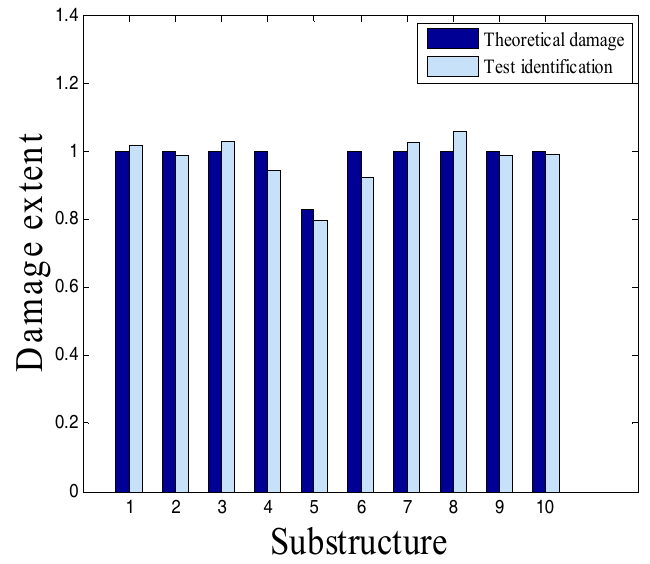
Figure20. The test damage identification. Figure 20. The test damage